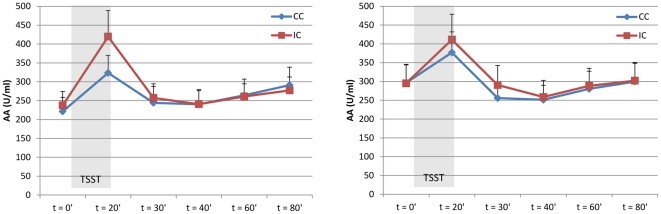
Autonomic response to stress.Mean stress-induced α-amylase levels (± SEM) of patients in the intervention (IC) and control (CC) conditions at post-treatment (left; ICAA = 9; CCAA = 3) and at follow-up (right; ICAA = 35; CCAA = 31).